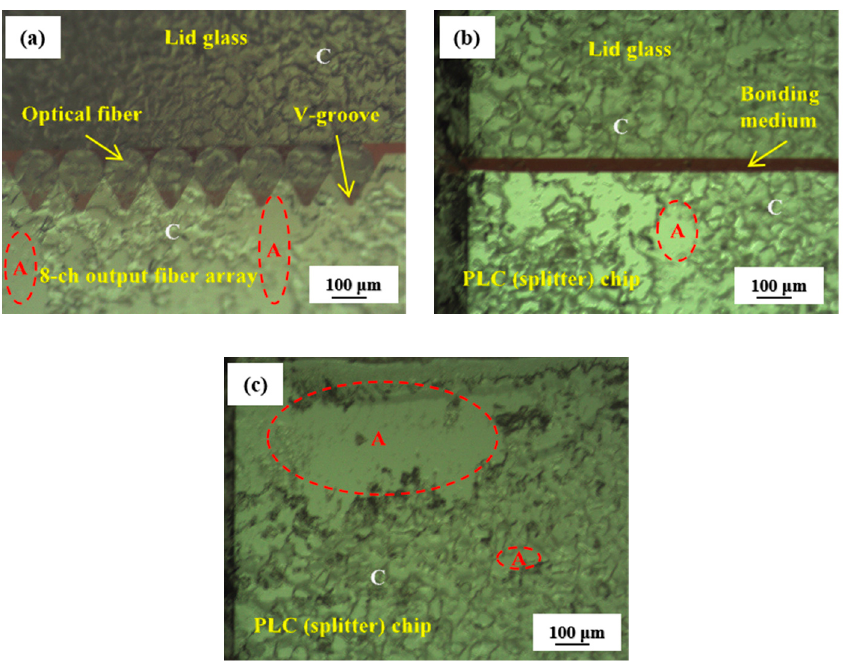
Figure 3. Typical optical micrograph of fracture surfaces of a Type I fracture: ( a ) 8-channel fiber array end face; ( b ) PLC chip end face (the bonging medium in the picture is used to bond the lid glass to the PLC chip); ( c ) edge of PLC chip end face. (A = adhesive/interfacial failure, C = cohesive failure).